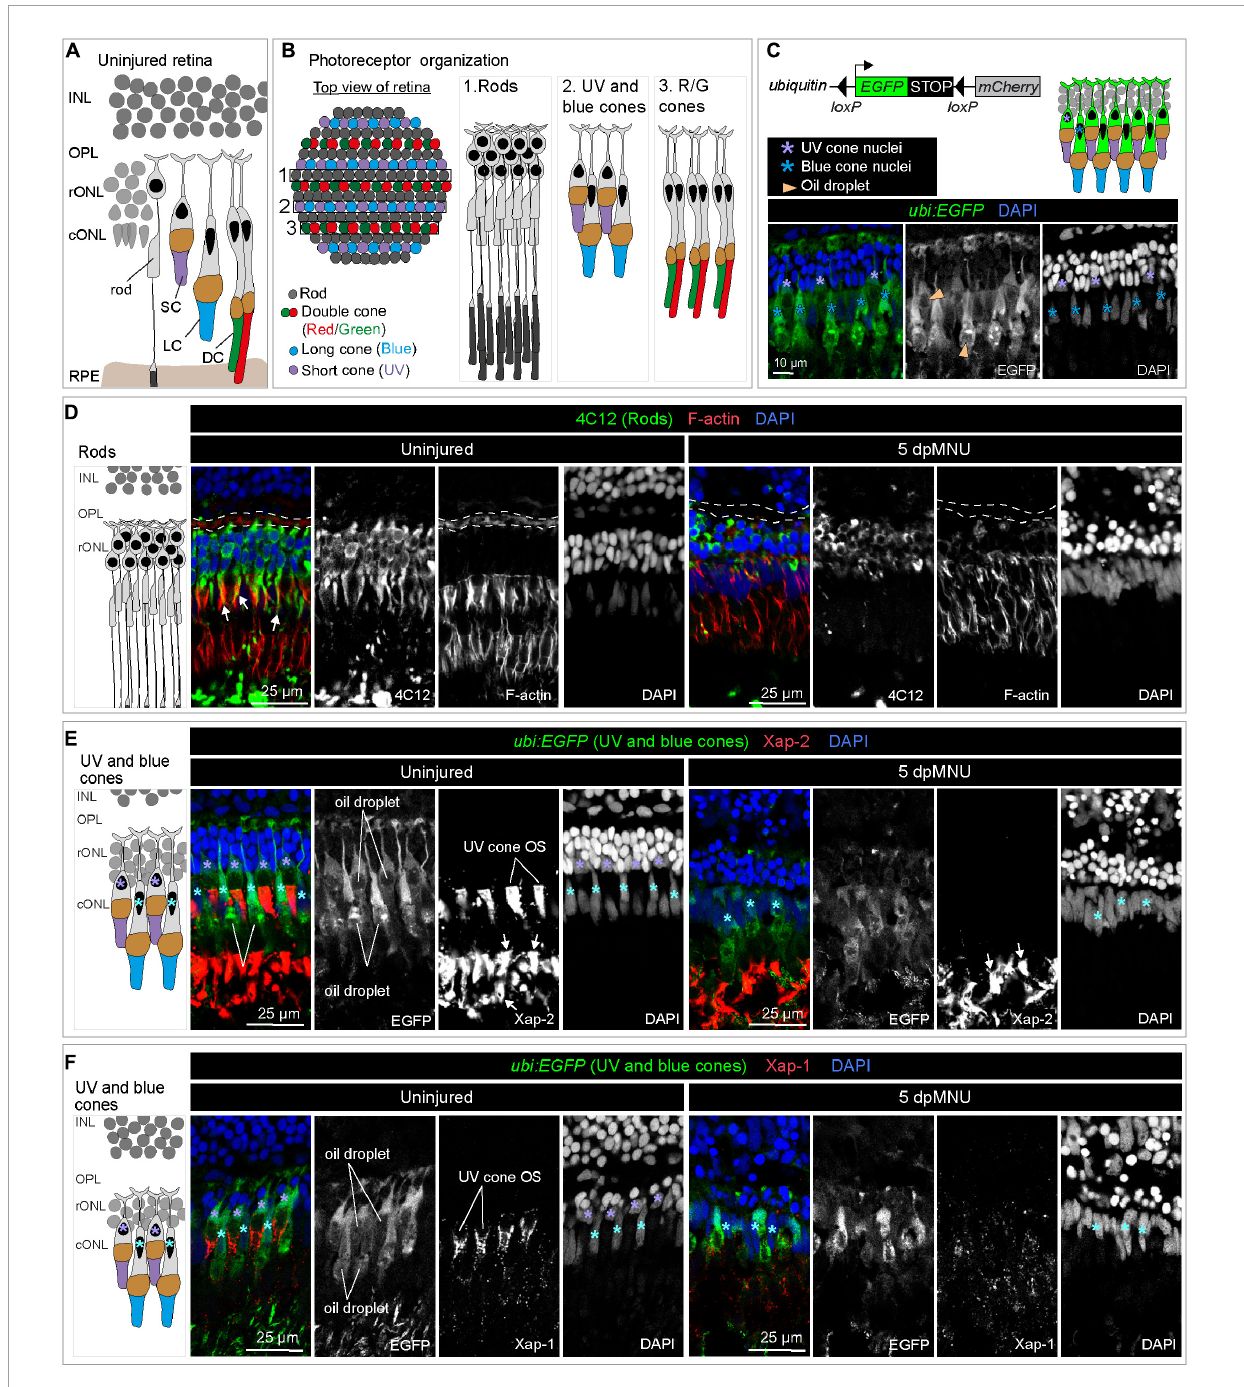
FIGURE3 MNU-mediated injury predominantly affects rods, UV-cones and the outer plexiform layer. Schematics of photoreceptor organization in a transversal section (A) and frontal flattened view (B) , based on Raymond and Barthel (2004), Lagman et al. (2015), and Noel et al. (2021). INL, inner nuclear layer; rONL, rod outer nuclear layer; cONL, cone outer nuclear layer; OPL, outer plexiform layer; RPE, retinal pigmented epithelium; DC, double cones (red/green spectral sensitivity); LC, long single cones (blue spectral sensitivity); SC, short single cone (UV spectral sensitivity). (C) Ubiquitin-promoter driven loxP-EGFP-loxP-mCherry transgene is expressed in blue and UV cones. Top panel shows a schematic illustration and the bottom panel displays a section of uninjured retina with ubi:EGFP transgene expression (green) and DAPI (blue). (D) Transversal retinal section stained with 4C12 antibody to visualize cell bodies and inner segments of rods (green), Phalloidin to detect F-actin (red) and DAPI (blue). In uninjured retina, colocalization between 4C12 and Phalloidin (arrows) is detected at the level of inner segments. F-actin is also present in the photoreceptor processes in the outer plexiform layer (outlined with a dashed lines). At 5 dpMNU, F-actin in the outer plexiform layer is missing and rod cells bodies and their inner segments are disorganized. (E) Identification of Xap-2 antibody (red) as a marker of photoreceptor outer segments on section of ubi:EGFP transgenic retinas. A strong expression is detected distally to the oil droplet in the UV cones (purple asterisks) and blue cones (cyan asterisks). (F) Identification of Xap-1 antibody (red) as a marker of the cone outer segment on section of ubi:EGFP transgenic retinas. A dotty localization of Xap1 is enriched distally to the oil droplet in the UV cones (purple asterisks). Dots of Xap-1 labeling are also observed in the outer segments of other photoreceptors, but at much less concentrated level. N ≥